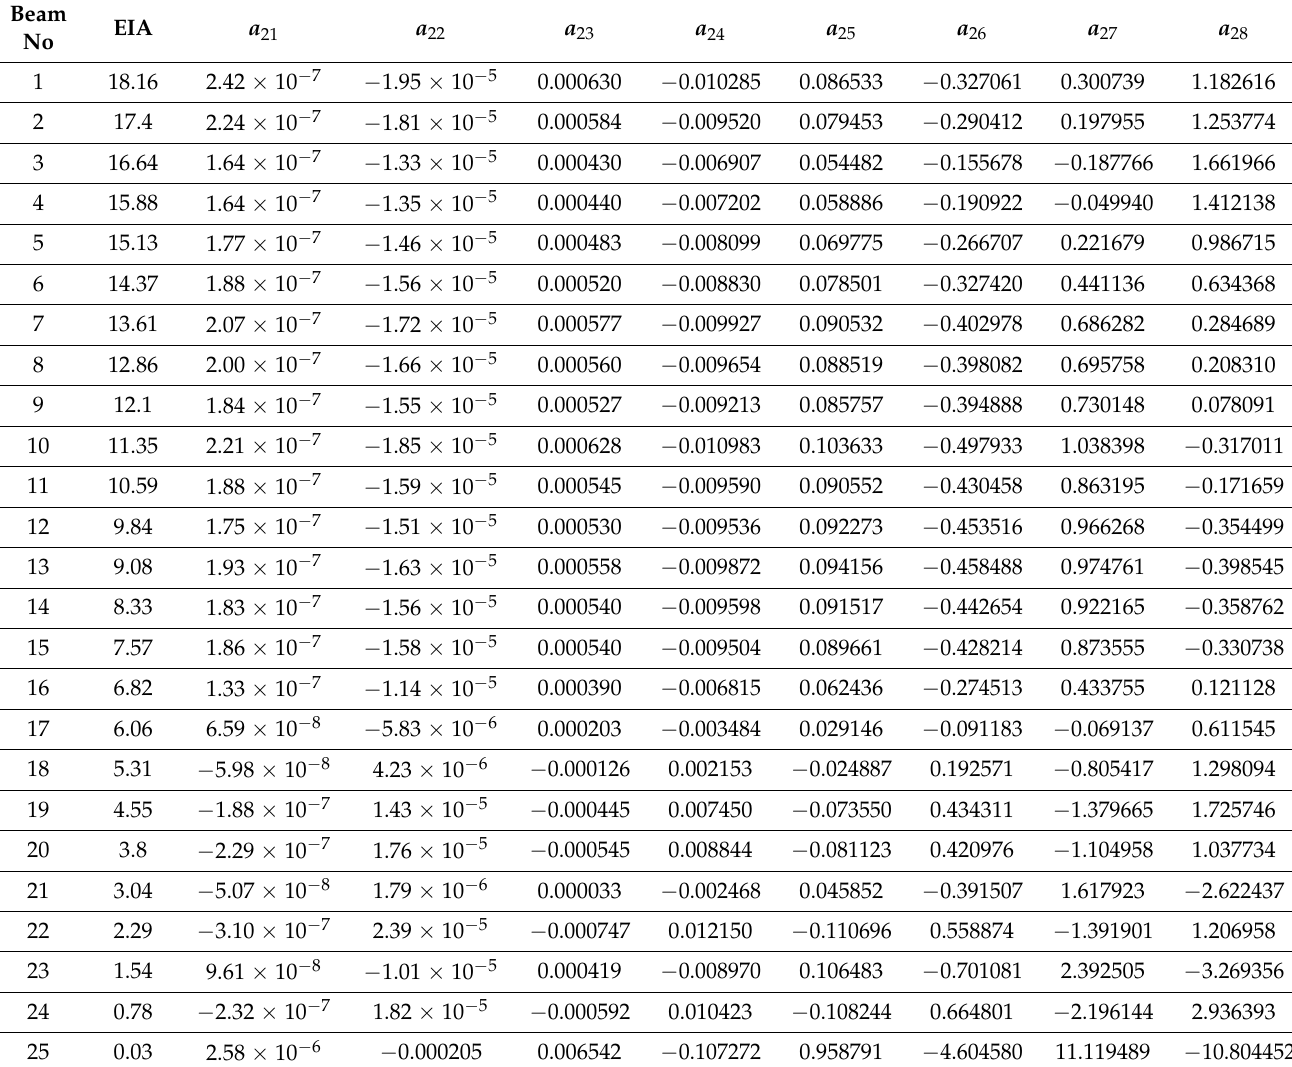
Table A4. Polynomial coefficients for Ka-band A 2 model in dB (Equation